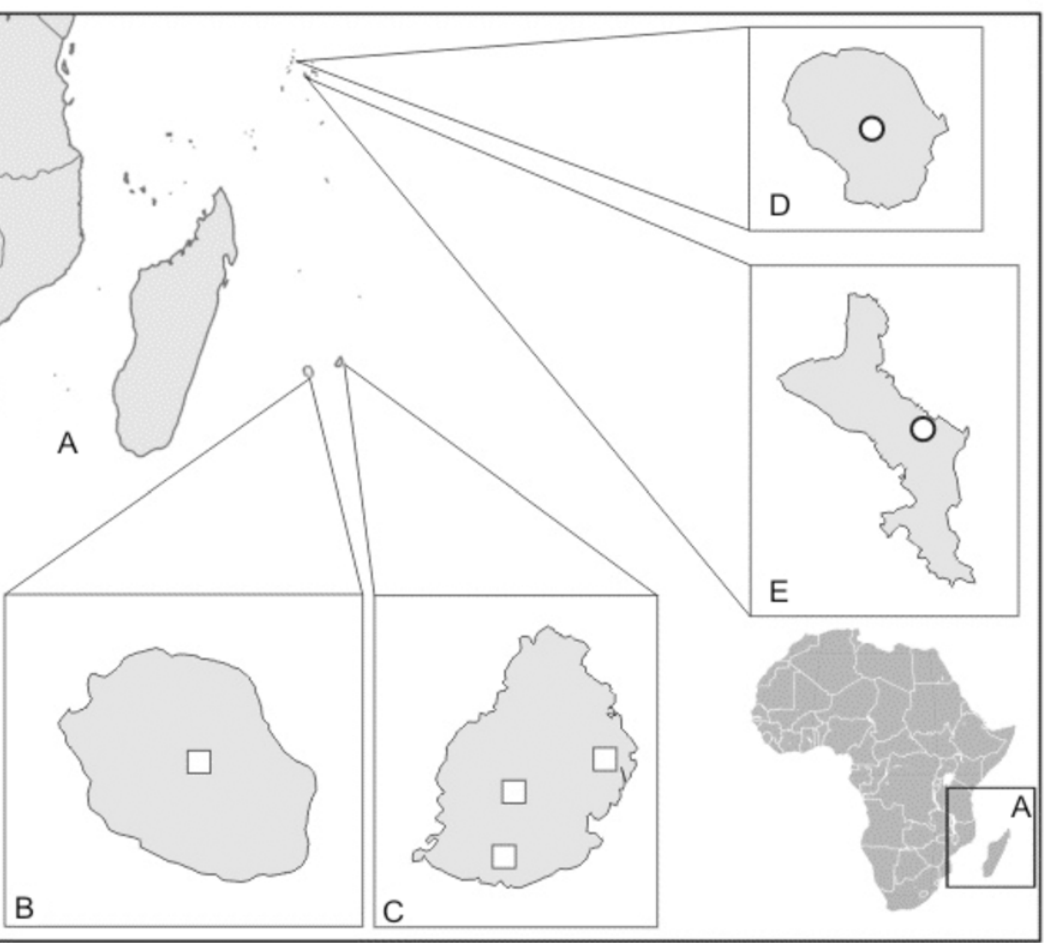
Fig 3. The distribution map of Hederorkis scandens Thouars (squares) and H . seychellensis Bosser (circles). A, East coast of Africa and Madagascar and neighboring islands. B, Réunion. C, Mauritius. D, Silhouette. E, Mahé.